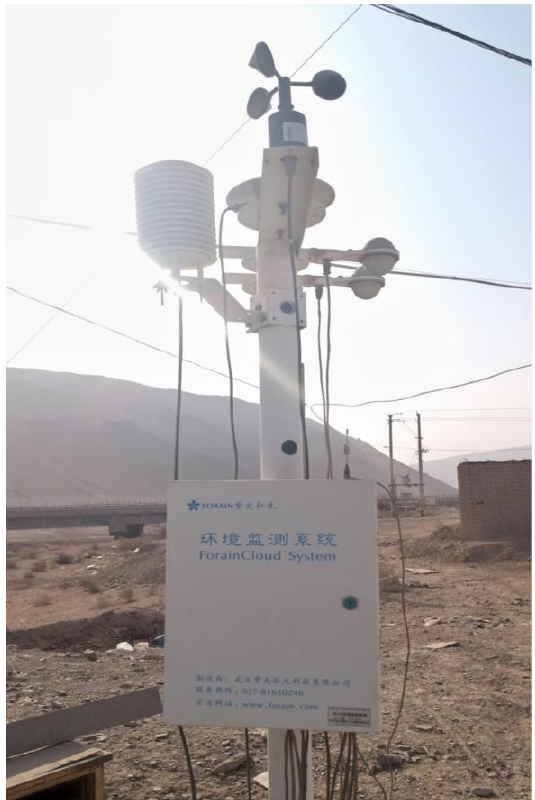
Figure 6. Automatic weather station used in the test. Note: The meaning of Chinese in the figure includes brand of weather station, equipment name, corporate name, contact telephone and official website address.